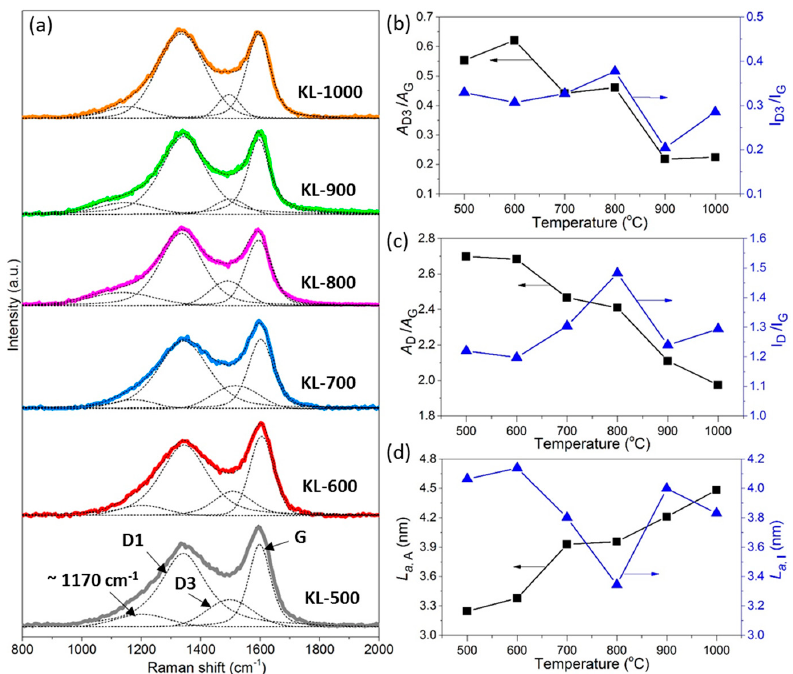
Figure 4. Raman analysis of KL-X samples: ( a ) Raman spectra for KL-X samples; ( b – d ) the influence of heating temperature on the structural parameters of KL-X samples; ( b ) the area and height ratio I D3 / I G of the D3 and G bands; ( c ) the area and height ratio I D / I G of the D and G bands; and ( d ) the nanocrystallite lateral size L a calculated from area and height intensity of D and G bands.